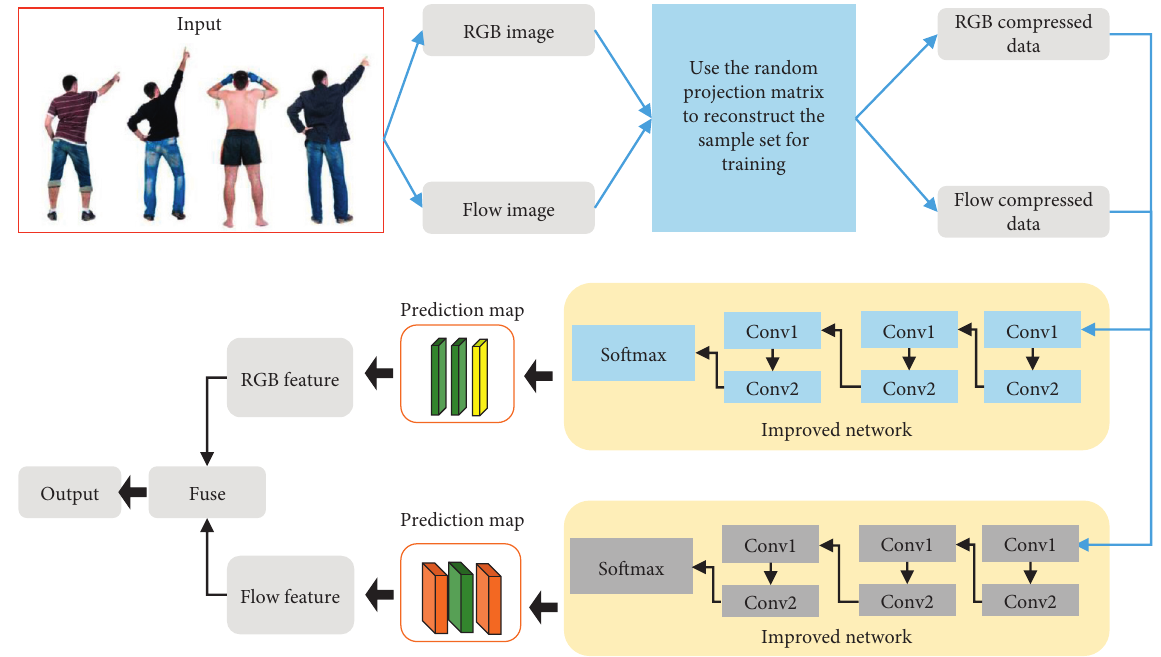
Figure 2: Schematic diagram of 3D convolutional neural network